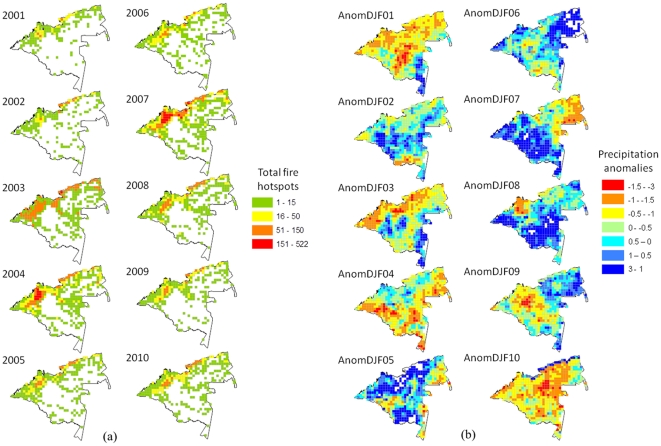
Spatial distribution of the (a) number of fire hotspots and (b) rainfall anomalies in the period including December of the previous year and January and February of the current year (DJF) from 2001 to 2010 in the entire study area.